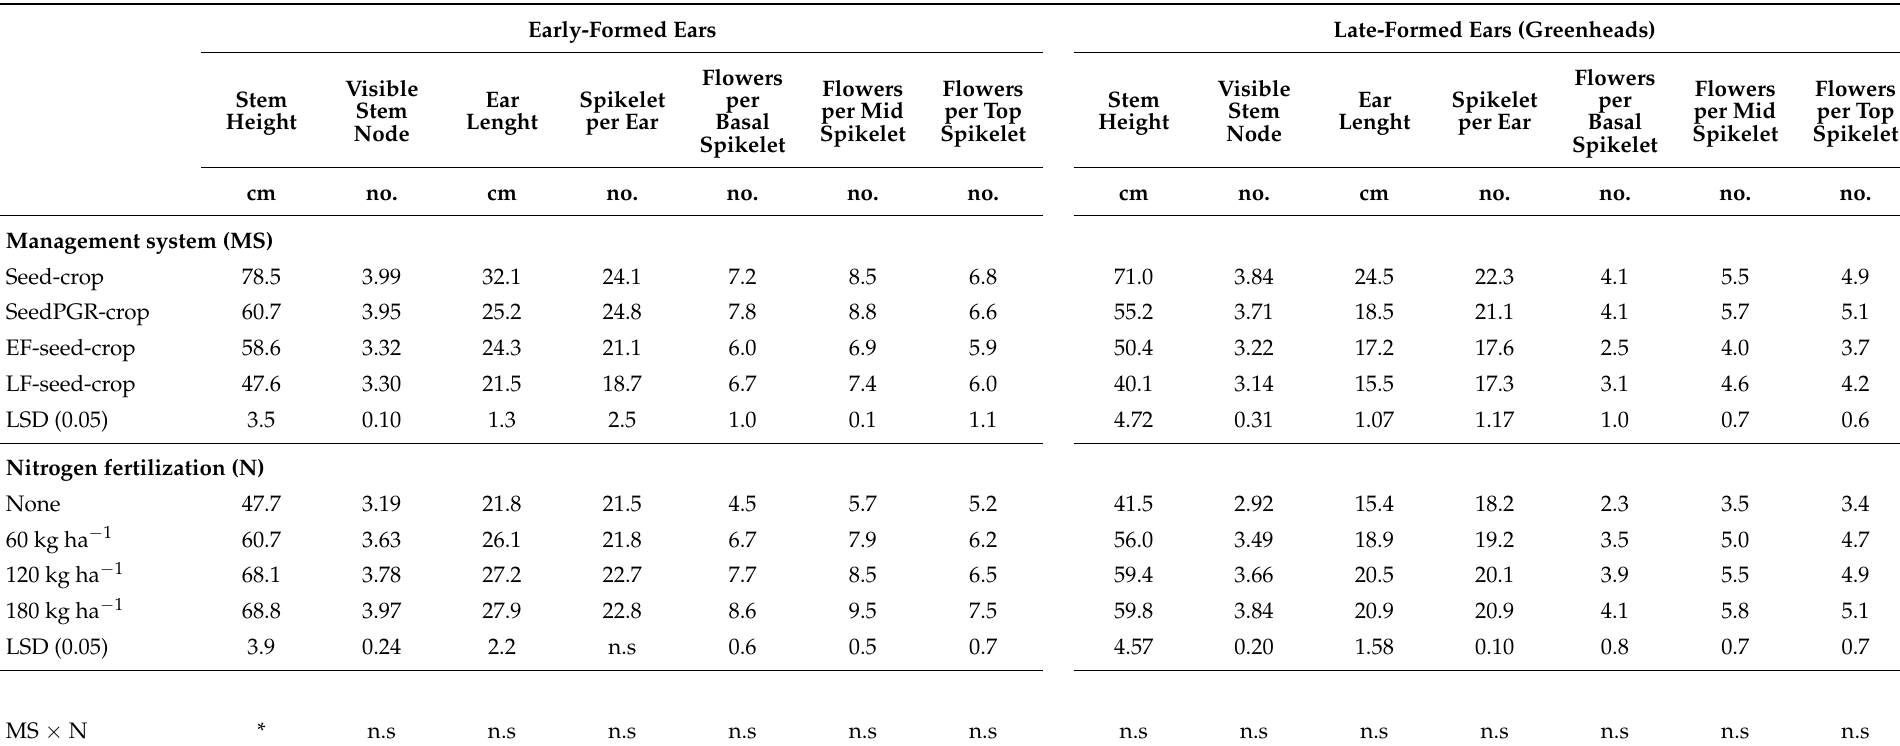
Table 3. Characteristics of early- and late-formed reproductive tillers of Italian ryegrass as affected by the management system and N fertilization. Early-Formed Ears Late-Formed Ears (Greenheads)